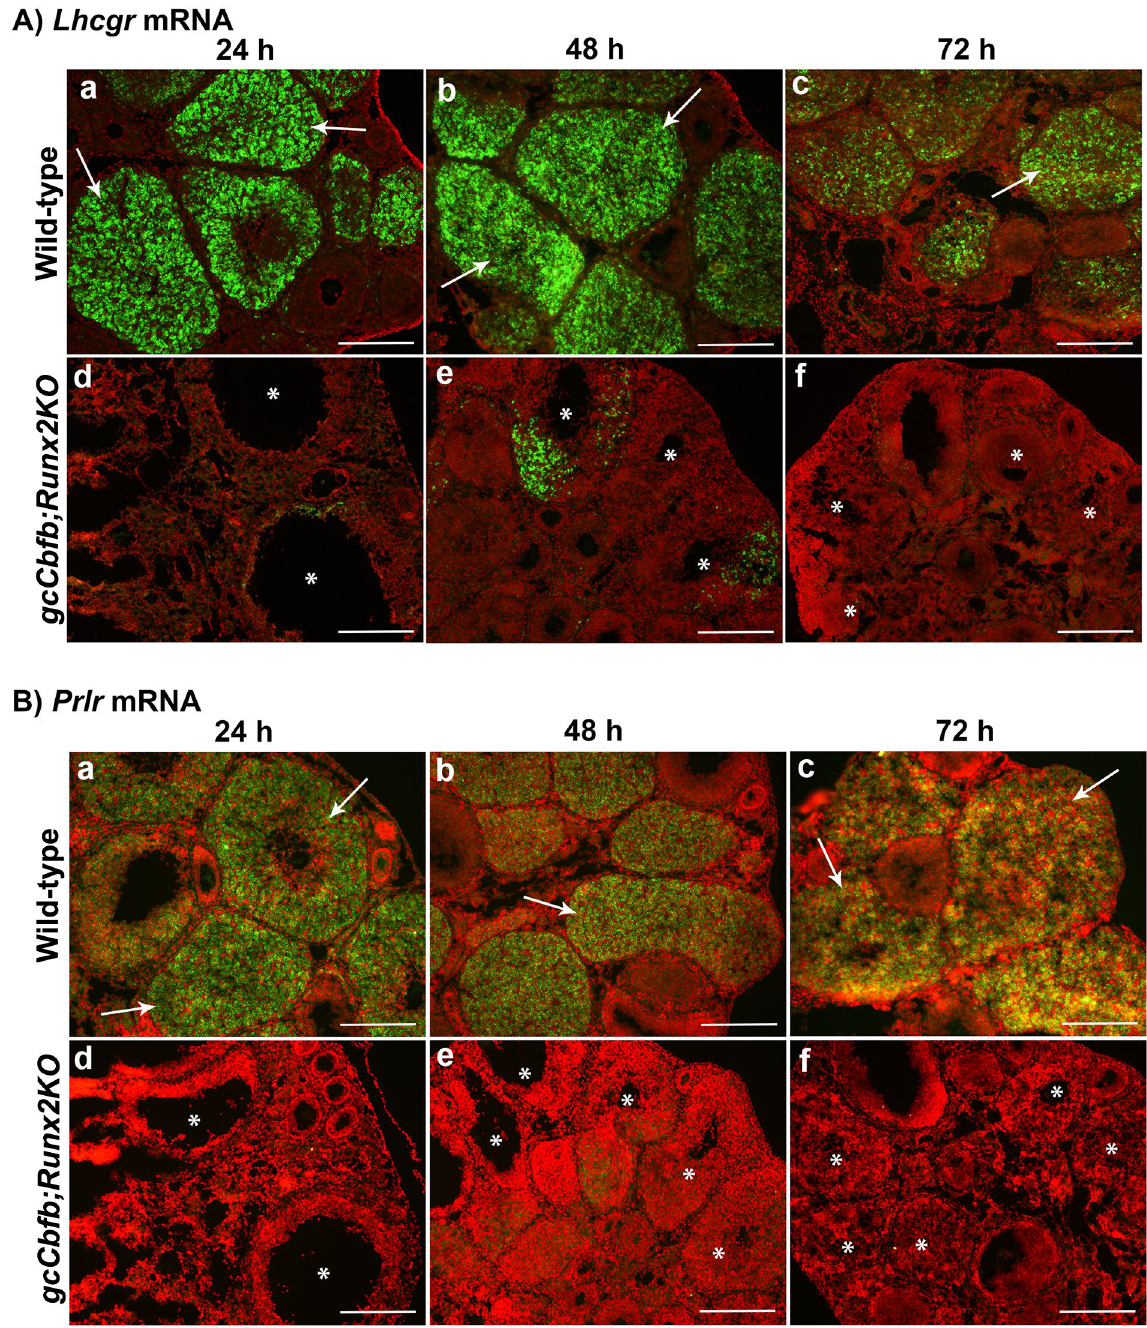
Figure 7. Assessment of the expression of Lhcgr and Prlr mRNA during the post-ovulatory period in gcCbfb;Runx2KO mice. Ovaries collected at 24, 48, and 72 h after hCG administration were used to examine the expression of mRNA for Lhcgr ( A ) and Prlr ( B ) by in situ hybridization analyses (n = 3 animals/genotype). Transcripts for each gene were detected as green fluorescence signals. The ovarian sections were counterstained with propidium iodide (red). Arrows point to the CL expressing Lhcgr and Prlr mRNA in control animals, and the symbol ( * ) was placed in unruptured follicles and poorly luteinized collapsed follicles in gcCbfb;Runx2KO mice. Scale bars, 250 μ m for all the